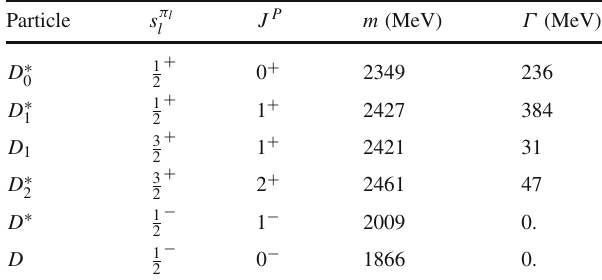
Table 4 Isospin averaged masses and widths of the six lightest charm mesons, rounded to 1MeV [99] (from Ref. [100])